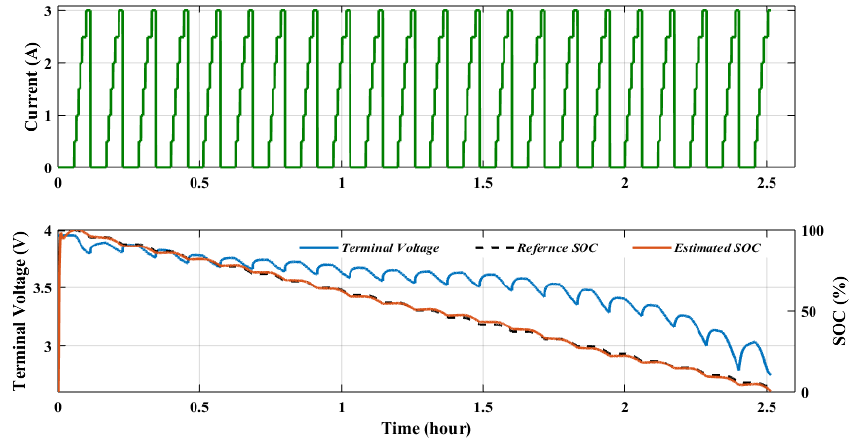
Figure 8. Terminal voltage, current, estimated SOC and reference SOC profiles for hybrid pulse experiment.